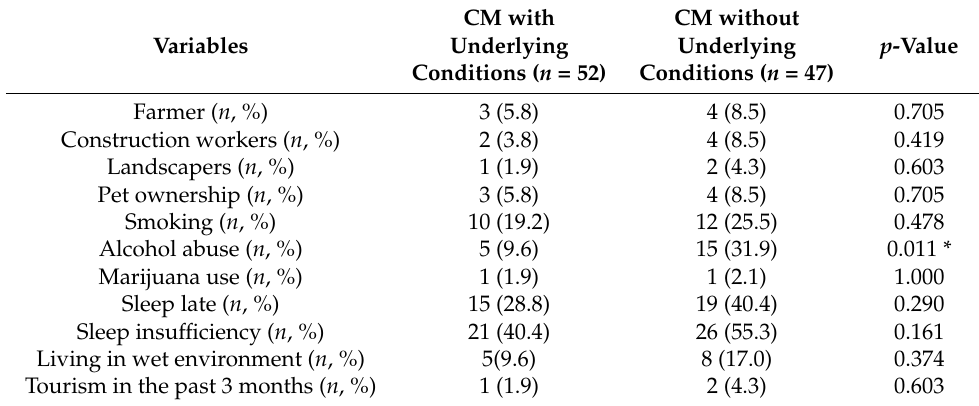
Table 3. Environmental exposures and lifestyle of CM patients with and without underlying condi- tions ( n =